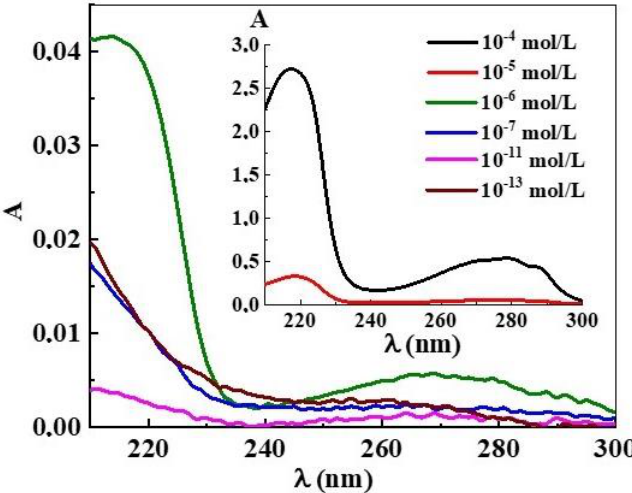
Figure 5. Absorption spectra of the L -Trp systems, 25 ◦ C. Insert: Absorption spectra of the L -Trp systems with concentrations of 1 × 10 −4 and 1 × 10 −5 mol/L